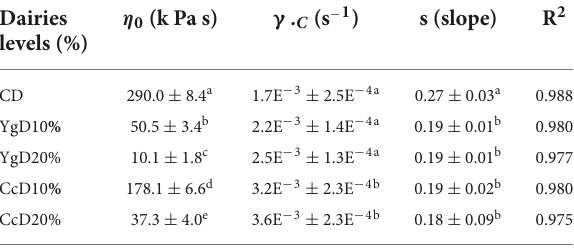
TABLE 2 Carreau model parameters obtained for control dough (CD) and doughs obtained with different levels of Yg (YgD) and curd cheese (CcD)